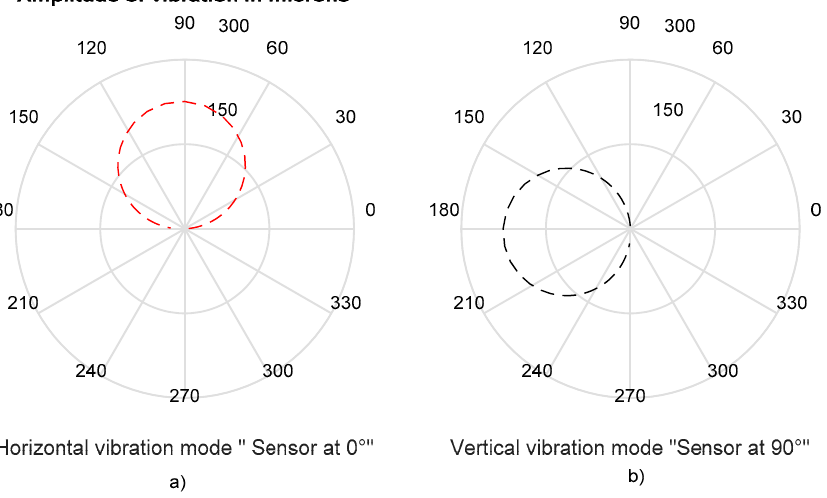
Figure 2. Decoupled vibration modes using 1-DOF Systems by ( a ) horizontal and ( b ) vertical directions.